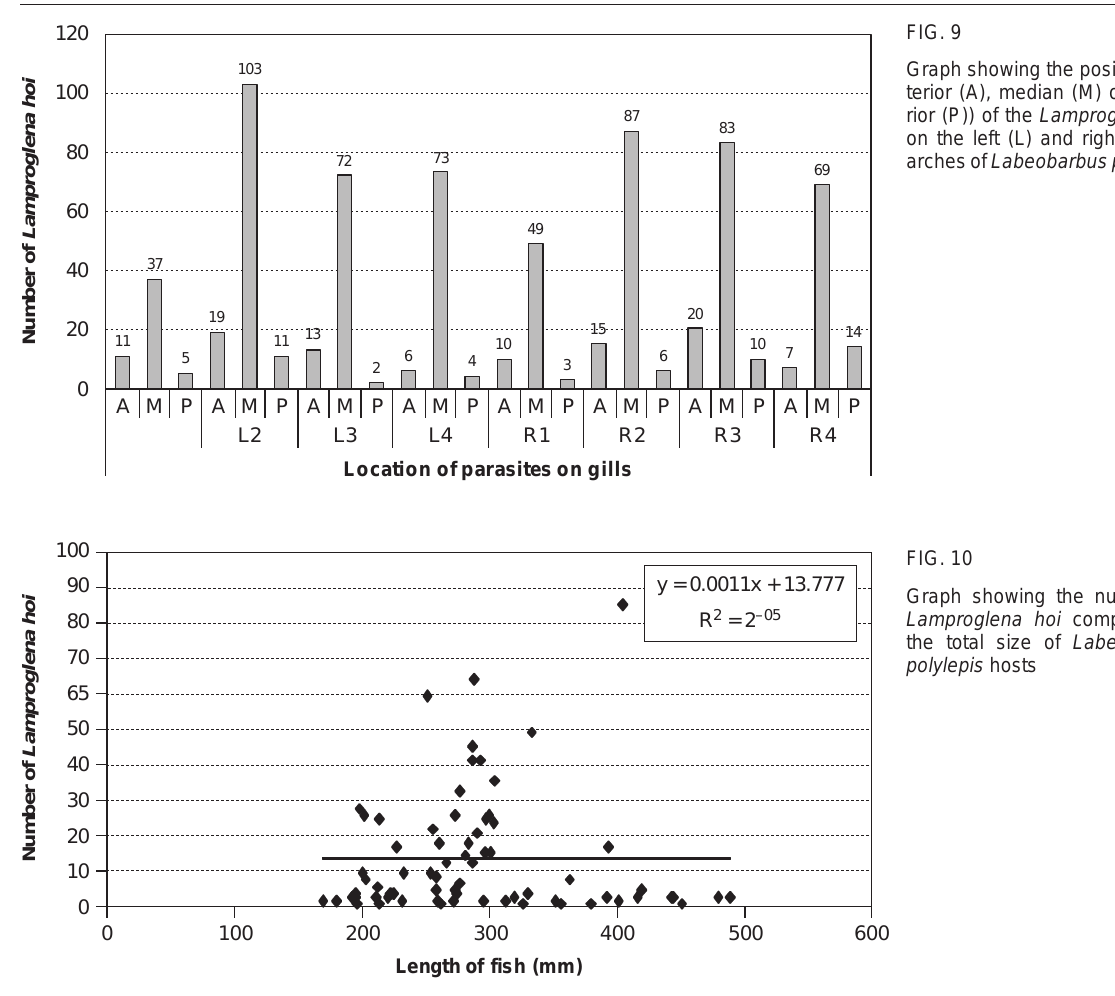
Graph showing the number of Lamproglena hoi compared to the total size of Labeobarbus poly lepis